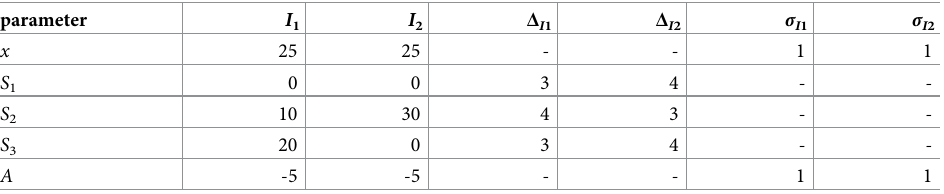
Table 5. Model input parameters for 2D calculations with two isotope signatures I 1 , I 2 and three sources: S 1 , S 2 , S 3 . parameter I 1 I 2 Δ I 1 Δ I 2 σ I 1 σ I 2 x 25 25 - - 1 1 S 1 0 0 3 4 - - S 2 10 30 4 3 - - S 3 20 0 3 4 - - A -5 -5 - - 1